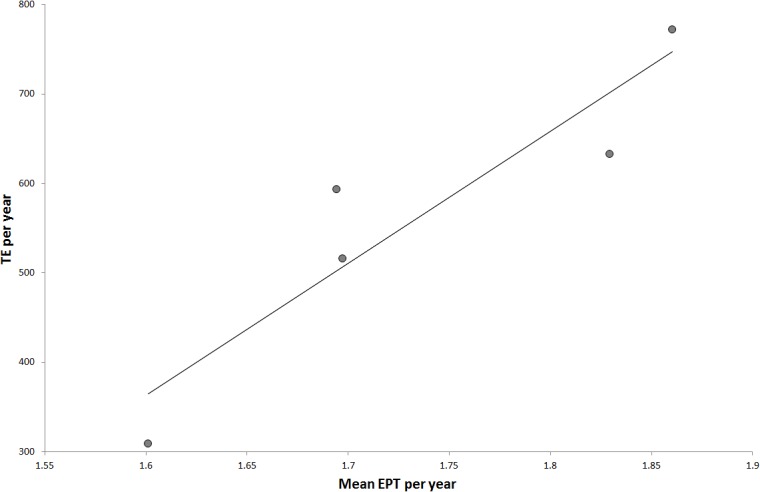
Relationships between TE (total encounters) per year and mean EPT (encounters per trip).TE year-1 = 1476EPT year-1–1999, R2 = 0.86, p = 0.046.